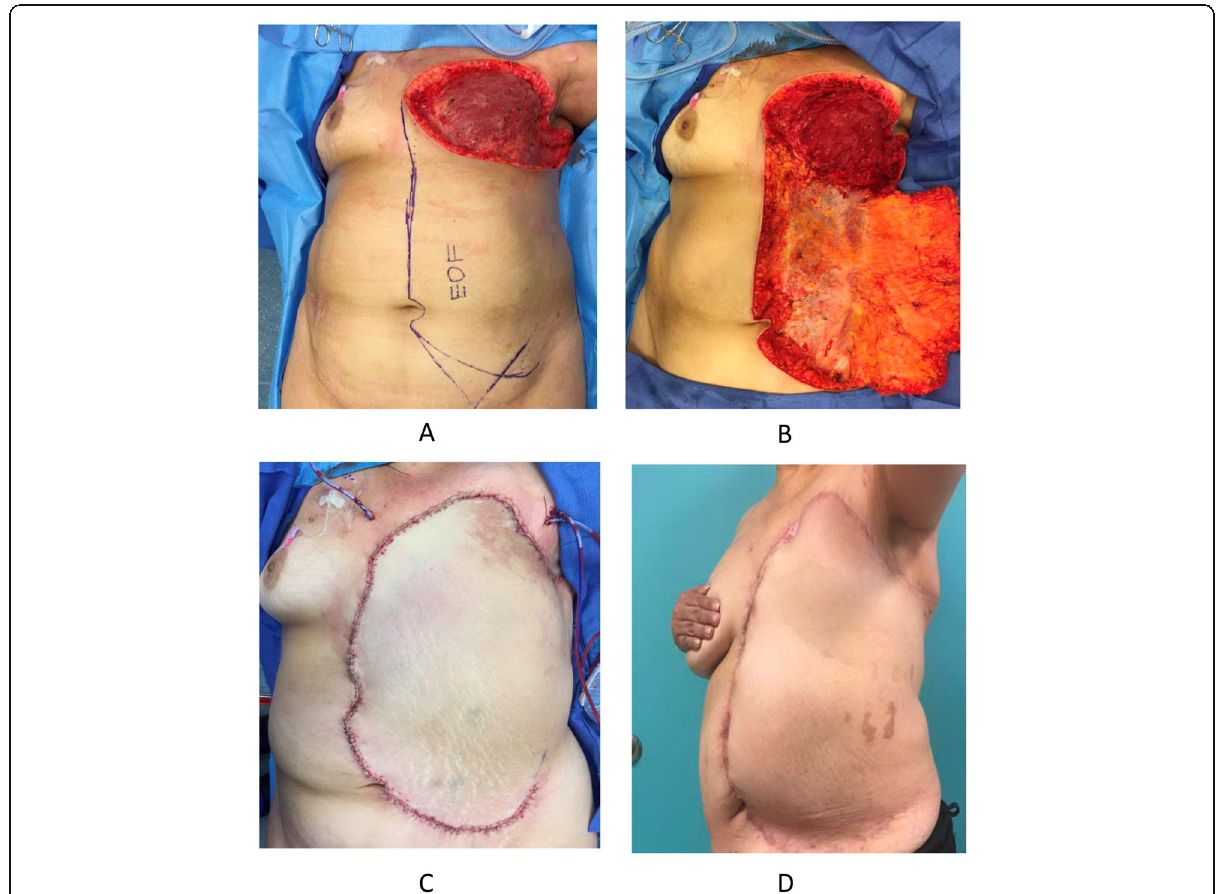
Fig. 1 Intraoperative thoracic wall defect status post wide local excision. a Resected tumor requiring external oblique musculocutaneous flap. b Image showing exposed external oblique muscle used for repair. c Postoperative results showing a repaired defect of 30 cm × 30 cm. d Image showing appropriate wound healing after 6 months status post